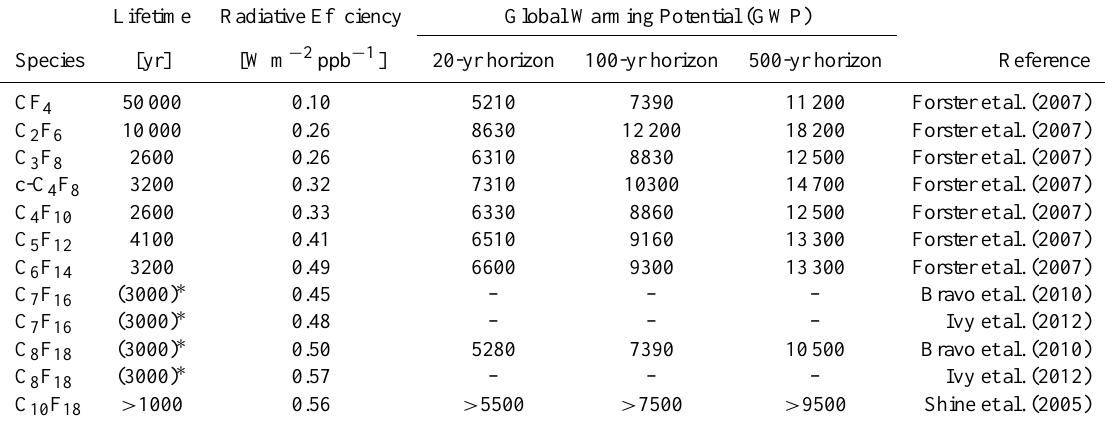
Table 1. Lifetimes, Radiative Efficiencies and Global Warming Potentials of Perfluorocarbons. Lifetime Radiative